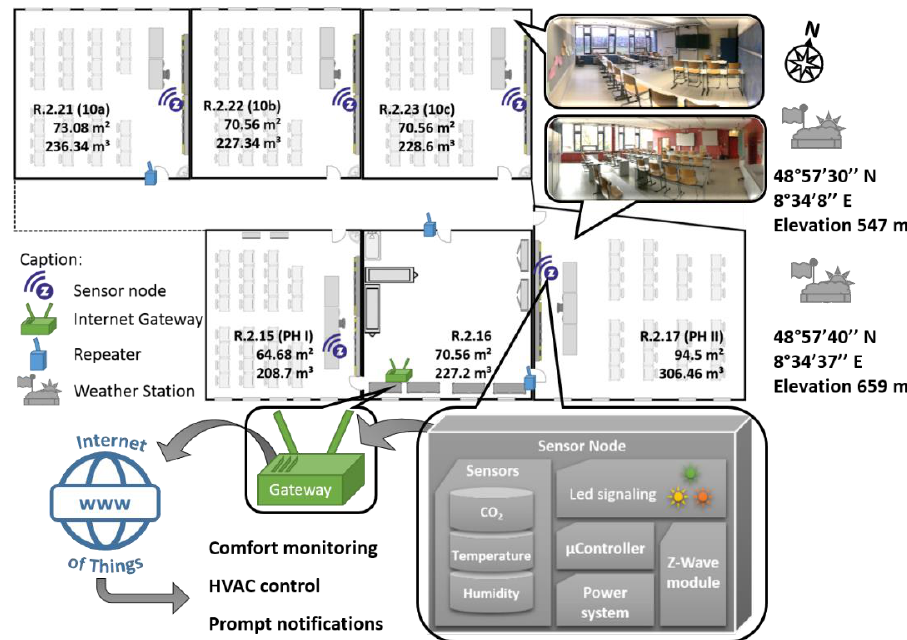
Figure 2. Overview of the system installation at the school. Each sensor node is installed at about 1 m height above ground. To ensure reliable data transfer three signal repeaters have been installed. Area and volume of all rooms are annotated in the schematic map and the position of each sensor node is indicated above.